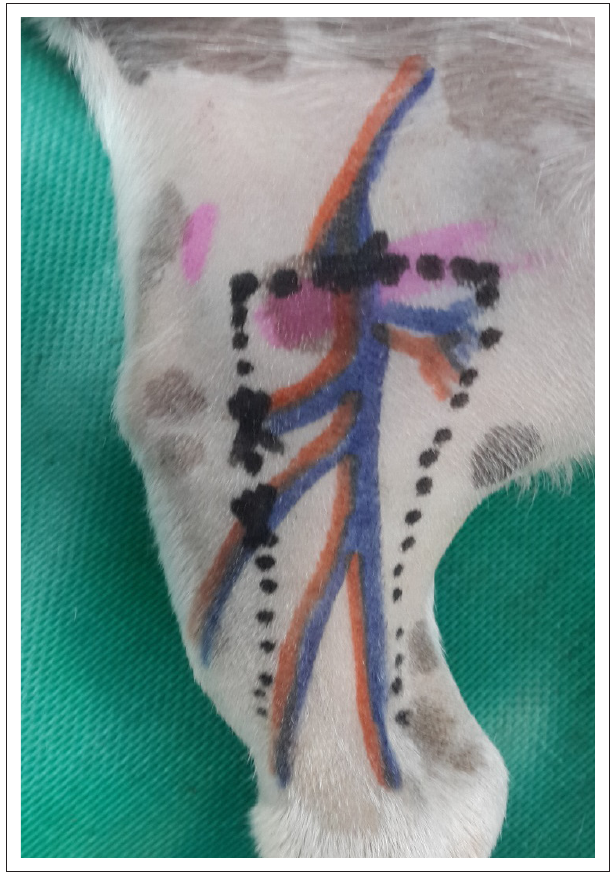
FIGURE 3: Site of the